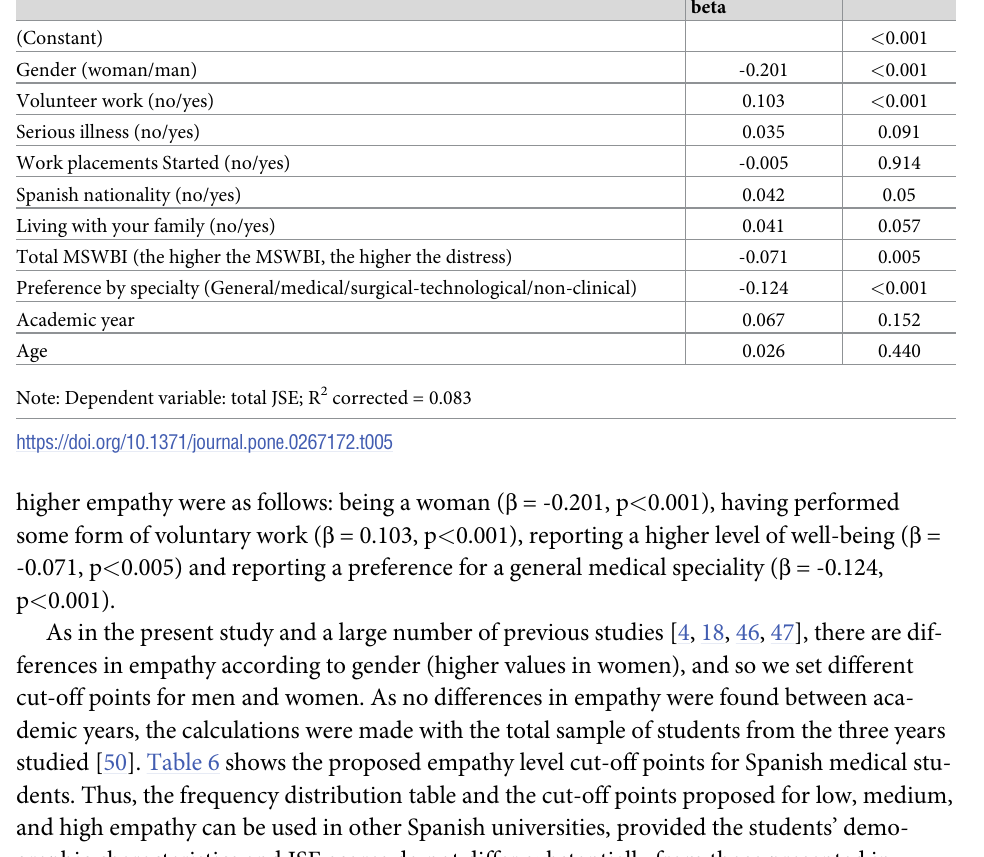
Table 6. Proposal for cut-off points of empathy levels in Spain after analyzing Jefferson Scale of Empathy scores in 2,268 students in Madrid (EMMA). Level